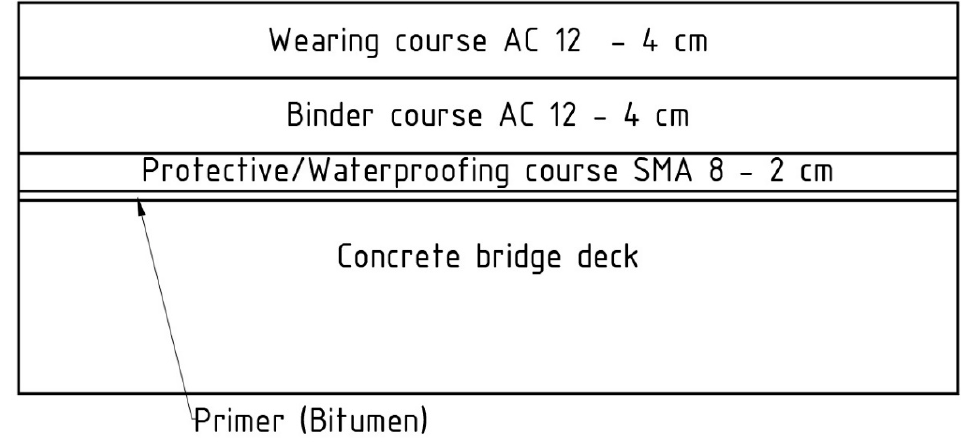
Figure 7. Structure of pavement on the Cłowy Bridge in Szczecin (constructed in 1998).